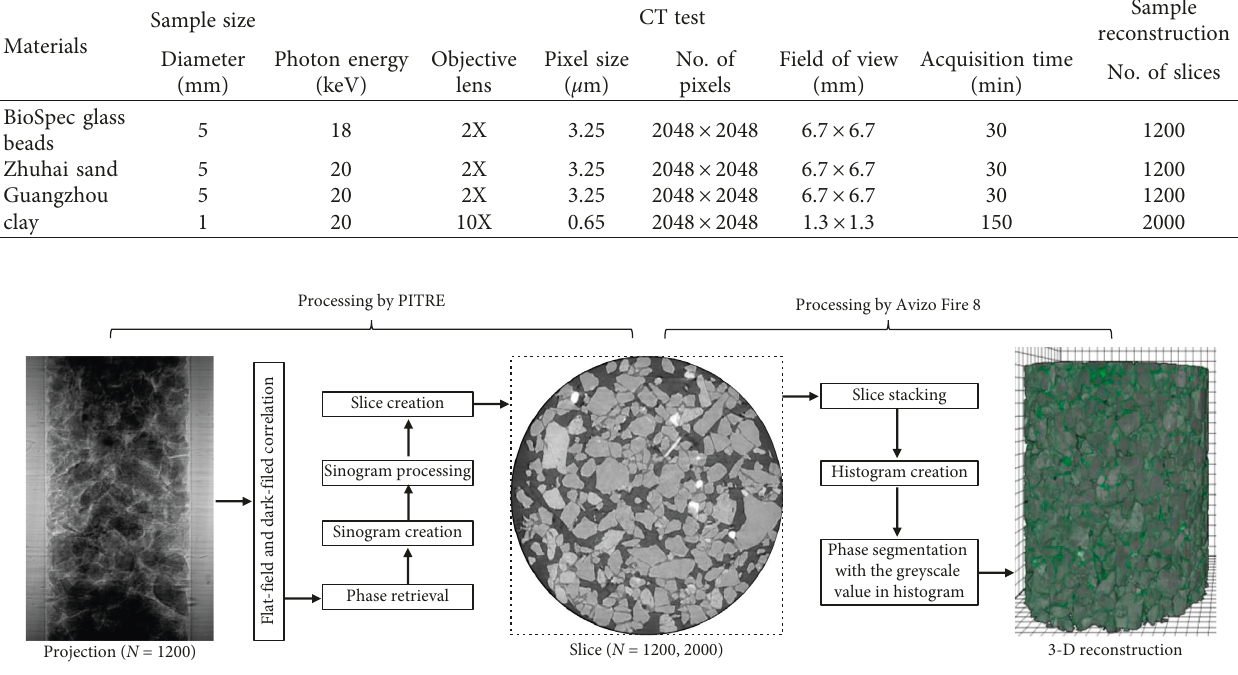
Figure 4: Phase retrieval, slice creation, and 3D reconstruction of a soil